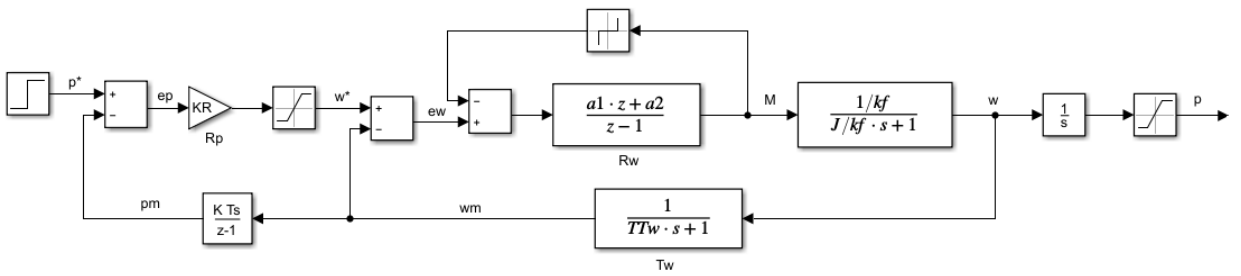
Figure 4. Block diagram of digital control system with limitations.